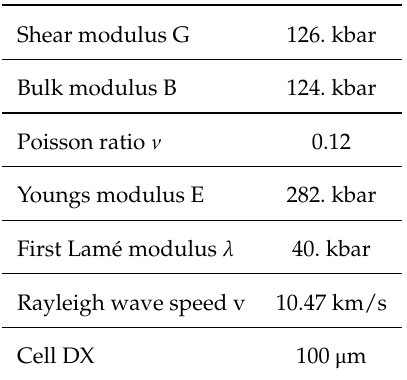
Table 1. Material parameters simulating beryllium.